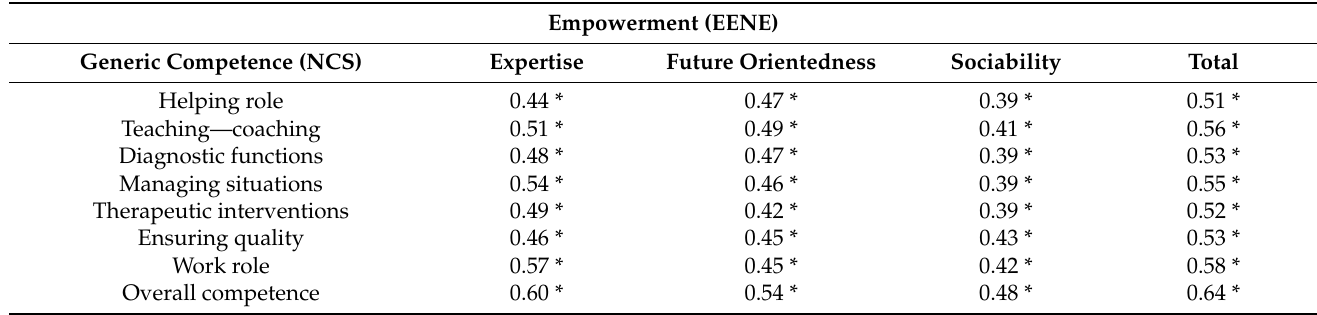
Table 4. Correlations between empowerment and generic competence (Pearson’s r) ( n = 1702).